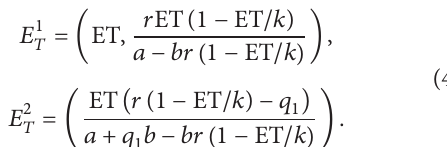
Figure 1: Notations for null-isoclines, regular/virtual equilibria, pseudoequilibrium, and sliding segment. The parameter values are fixed as follows: 𝑎 = 0.7 , 𝑏 = 0.6 , 𝑟 = 1.2 , 𝑘 = 12,𝛽 = 0.5 , 𝛿 = 0.25 , 𝑞